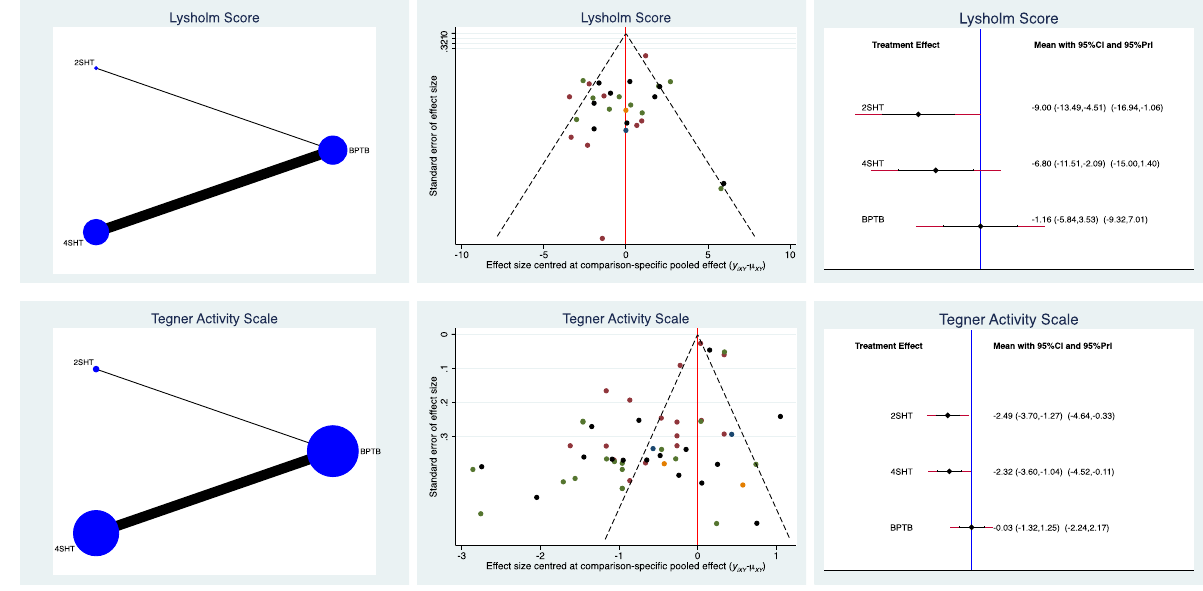
Figure 4. Edge, funnel, and interval plots of the network comparisons: PROMs.